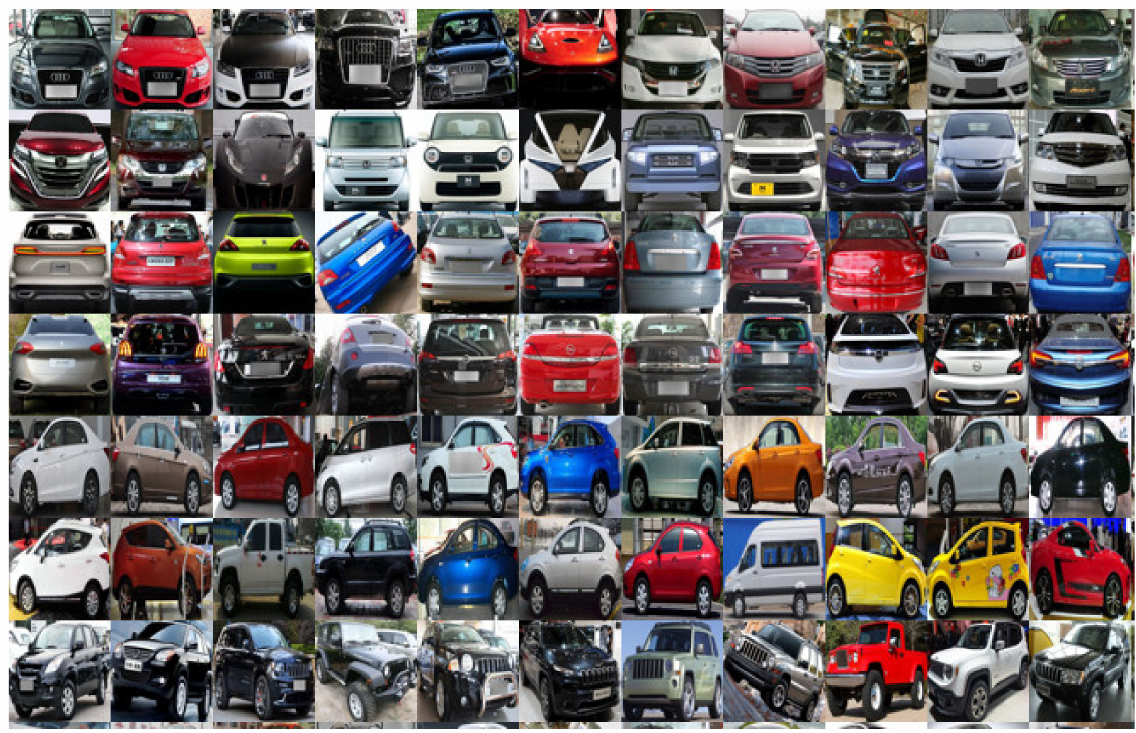
Figure 23. Depicts the sample images of CompCars